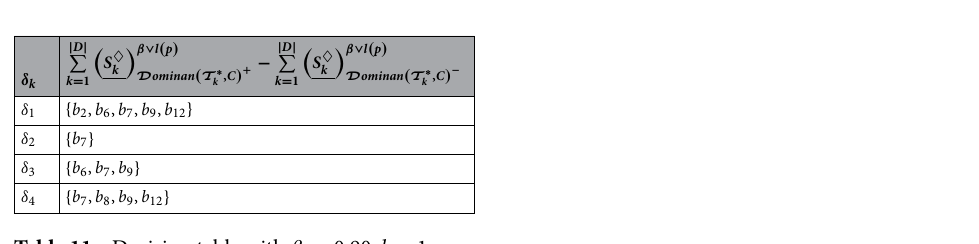
Table 11. Decision table with β = 0.90, l = 1